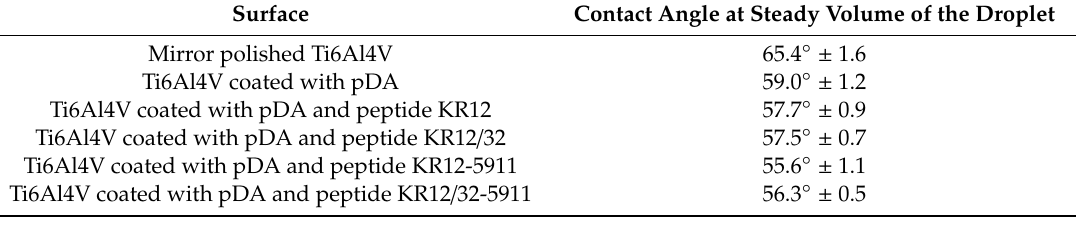
Table 6. Overview of the water contact angles during the steady droplet volume.